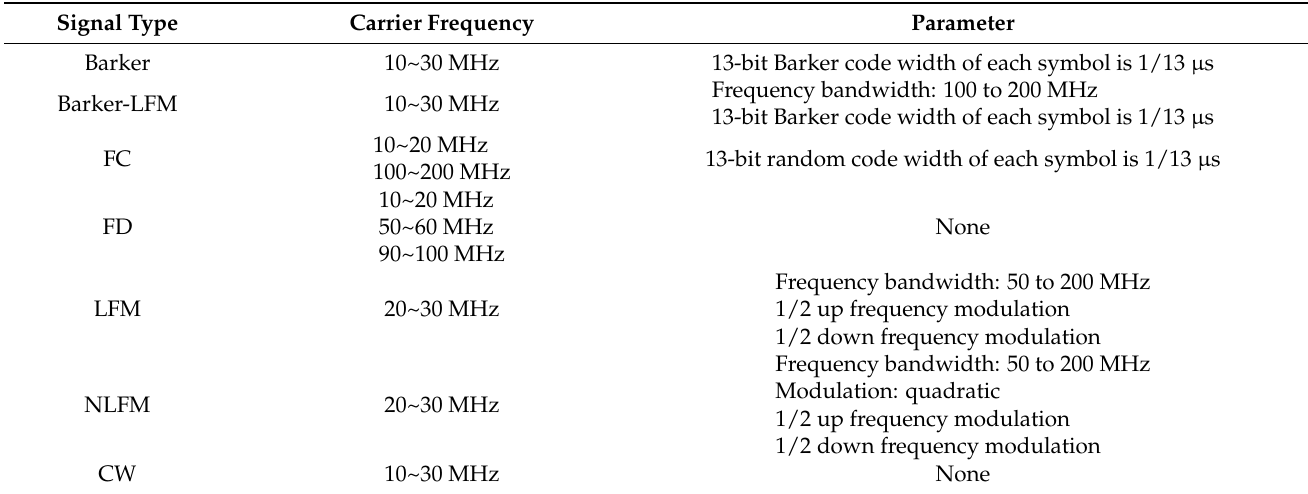
Table 2. Specific parameters of seven modulation type